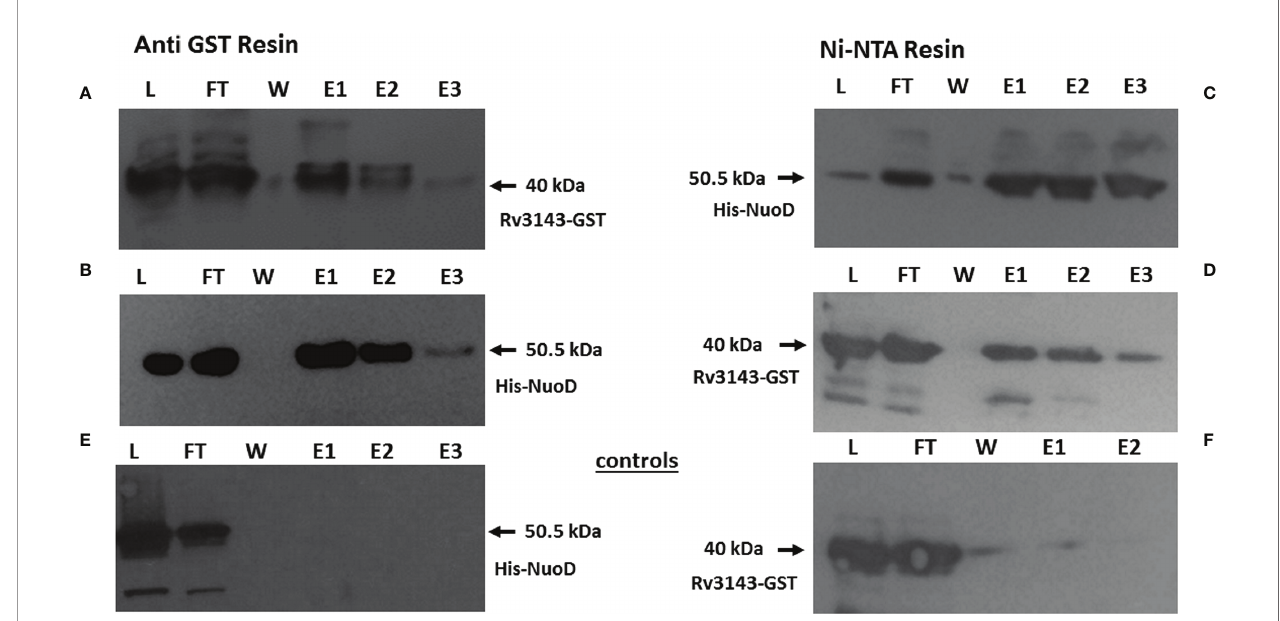
FIGURE 2 | Rv3143 protein interacts with NuoD in vitro . Immunoblots of NuoD pulled down with Rv3143 on anti-glutathione S-transferase (anti-GST) resin (A, B) . Immunoblots of Rv3143 pulled down with NuoD on Ni-NTA resin (C, D) . Bound proteins were eluted with imidazole, resolved on sodium dodecyl sulfate – polyacrylamide gel electrophoresis (SDS-PAGE) gels, transferred to polyvinylidene di fl uoride (PVDF) membranes, and probed with a -His and a -GST antibodies. L, load; FT, fl ow-through; W, wash; E, elution. (E, F) Non-speci fi c interactions of the tested